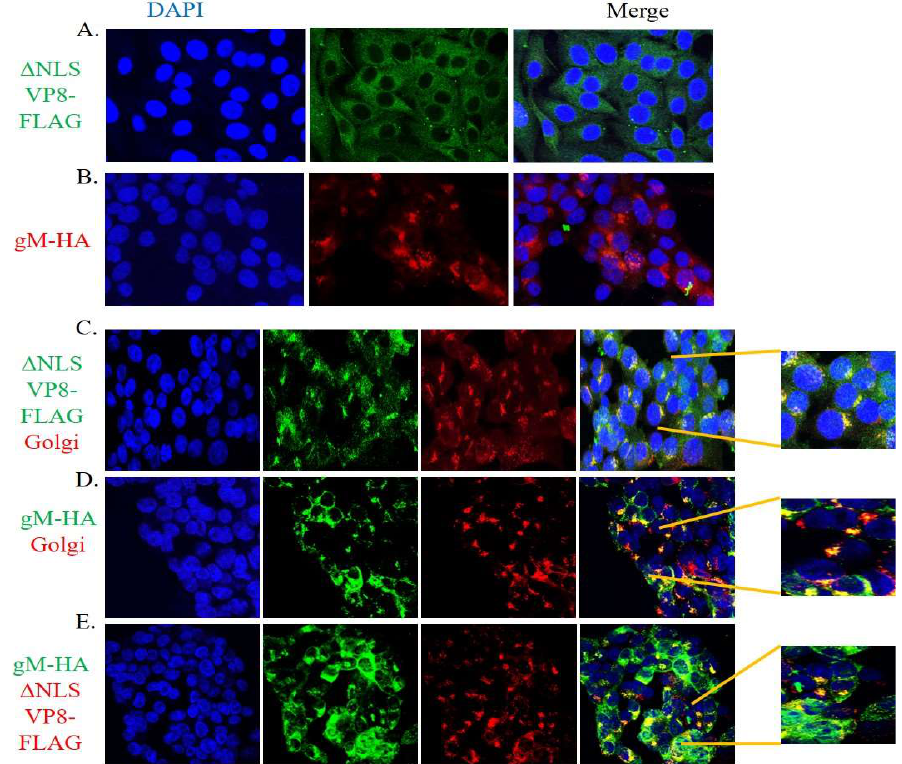
Figure 6. Localization of ΔNLS VP8-FLAG and gM-HA proteins in cells transfected with pΔNLS VP8-FLAG and pgM-HA individually ( A , B ) or in combination ( C – E ). EBTr cells transfected with ΔNLS VP8-FLAG and/or gM-HA were fixed and incubated with antibodies specific for VP8, gM, or Golgi. Alexa 488-conjugated goat anti-rabbit or goat anti-mouse IgG and Alexa 633-conjugated goat anti-rabbit or goat anti-mouse IgG were used to detect the primary antibodies. ( A ) Distribution of ΔNLS VP8-FLAG (green) in the cytoplasm. ( B ) Localization of gM-HA (red) in the Golgi. ( C ) ΔNLS VP8-FLAG (green), Golgi (red), and localization of VP8 in the Golgi in the merged image (yellow). ( D ) gM-HA (green), Golgi (red), and localization of gM in the Golgi in the merged image (yellow). ( E ) gM-HA (green) and ΔNLS VP8-FLAG (red), and co-localization of VP8 and gM as shown in the merged image (yellow). The nuclei were stained with Prolong gold DAPI. Cells in the boxes are magnified 5X. The cells were examined with a Leica SP8 confocal microscope. 3.3. A Domain between Amino Acids 538–632 in VP8 Interacts with a Domain between Amino Acids 210–300 in gM To identify the interaction domains of VP8 and gM, several C-terminal and N-termi- nal deletions were made in the VP8 and gM proteins, and the truncated versions were cloned into a plasmid with FLAG and HA tag, respectively. EBTr cells were co-transfected with the FLAG-tagged VP8-deletion mutants and full-length pgM-HA or HA-tagged gM- deletion mutants and full-length pVP8-FLAG and collected at 24 h post transfection. The expression of the truncated VP8 and gM proteins is shown in Figure 7A,B, respectively. Lysates from cells cotransfected with VP8 deletion mutants and full-length gM-HA were incubated with anti-FLAG resin, and those from cells co-transfected with gM-HA deletion mutants and full-length VP8 FLAG were incubated with anti-HA resin. The lysates were then eluted in SDS loading dye at 95 °C. When the eluates were subjected to Western blot- ting, with HA- and FLAG-specific antibodies for detection, VP8 was found to interact with amino acids 210–300 of gM (Figure 7C,D), while gM interacted with amino acids 538–632 of VP8 (Figure 7E). Figure 8A,B show a schematic of the interaction between the respective truncated proteins and full-length proteins, and the interaction domains on VP8 and gM,